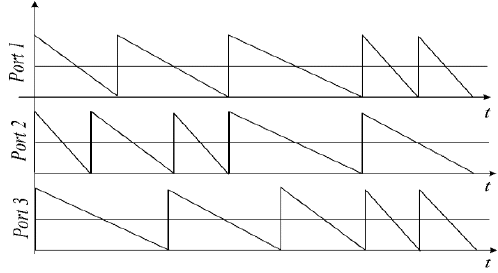
Figure 11. Independently chaotic modulation.